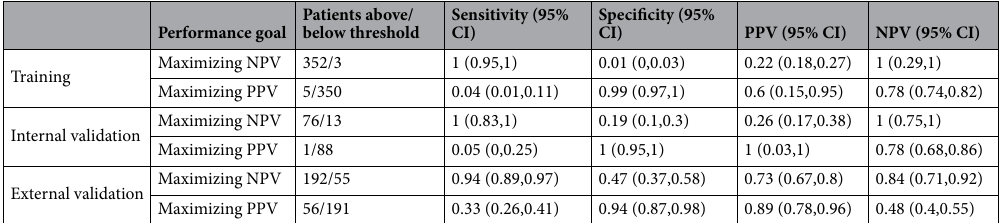
Table 6. Negative and positive predictive values for the Elastic net LR model and outcome of in-hospital mortality for patients over 50.